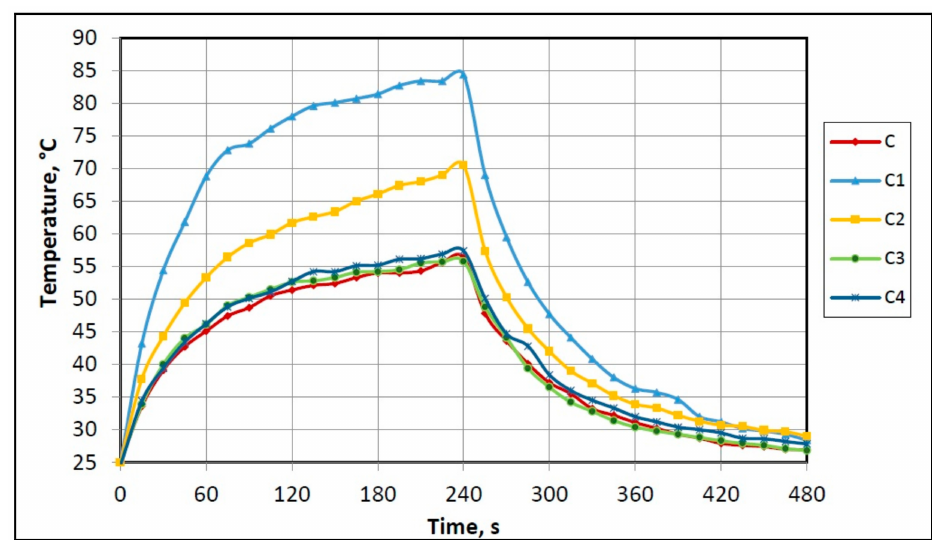
Figure 6. Dynamic thermal behavior of investigated